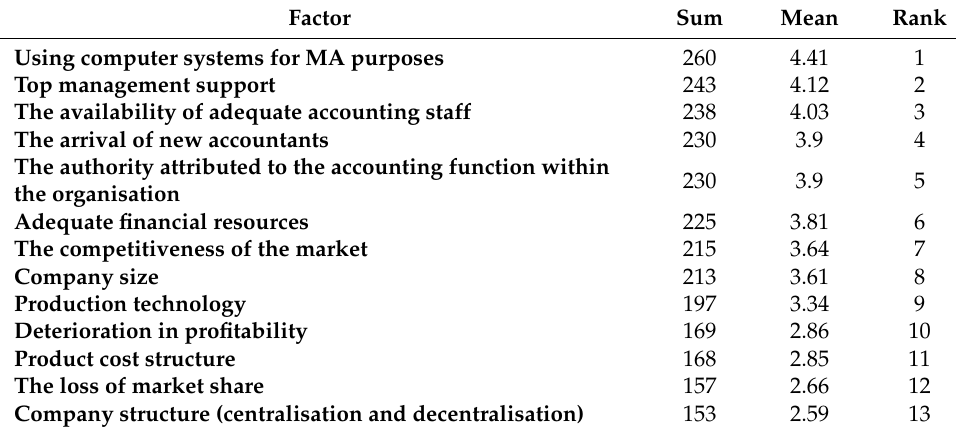
Table 12. Contingency factors facilitating the adoption of MAIs in the non-manufacturing sector.